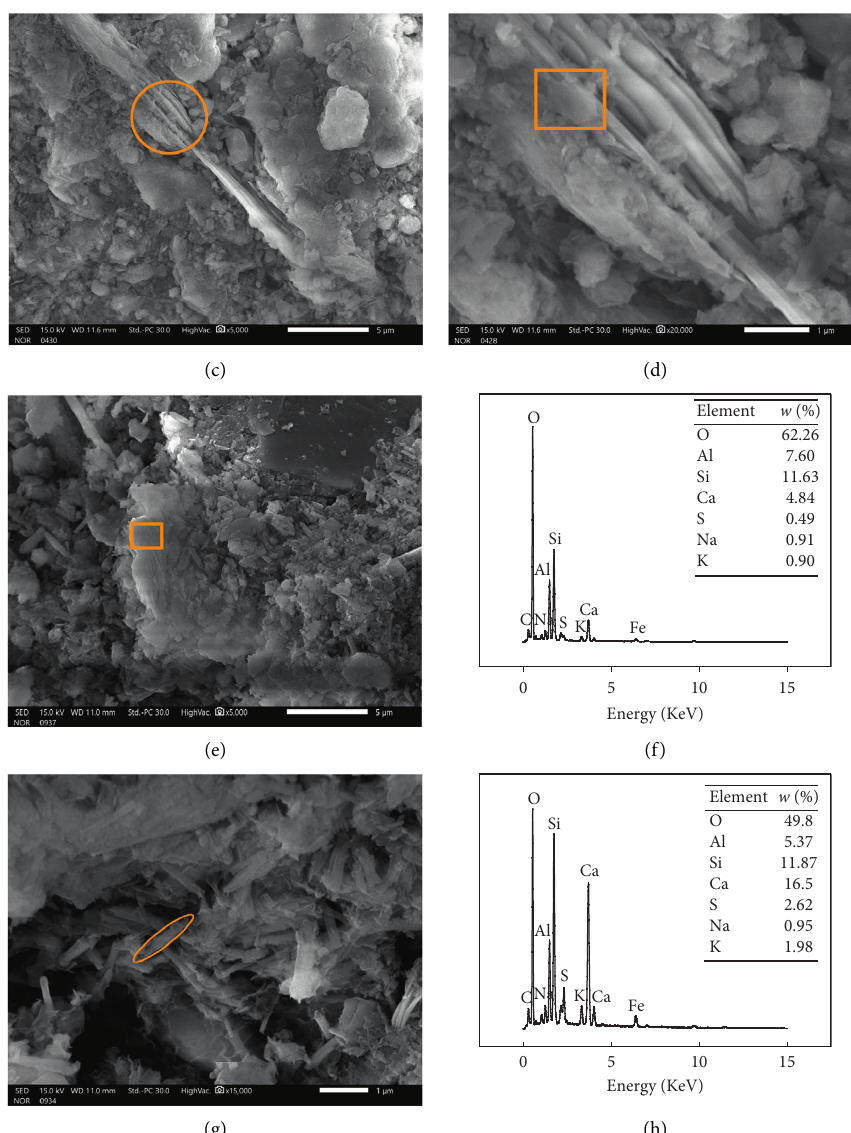
Figure 12: SEM and EDS analysis of RMCC ( C